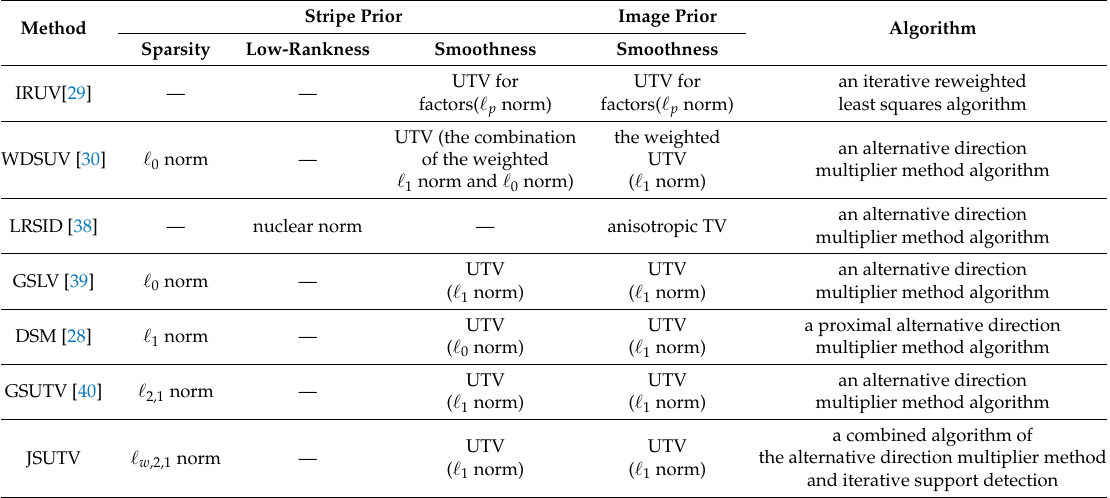
Table 1. A comparison of the related optimization-based methods and their properties. UTV, unidirectional total